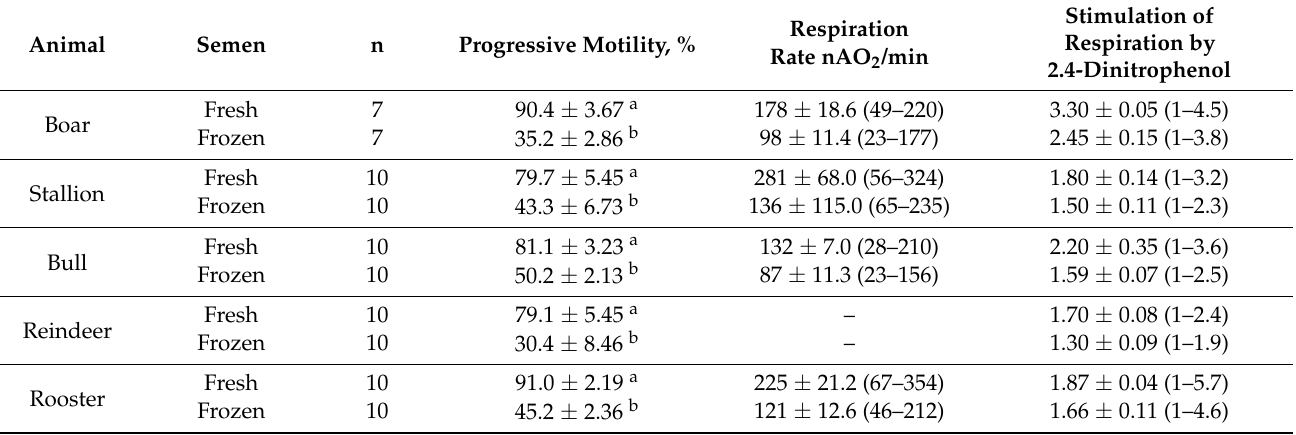
Table 1. Respiratory activity in sperm of boar, stallion, bull, reindeer and rooster semen before and after